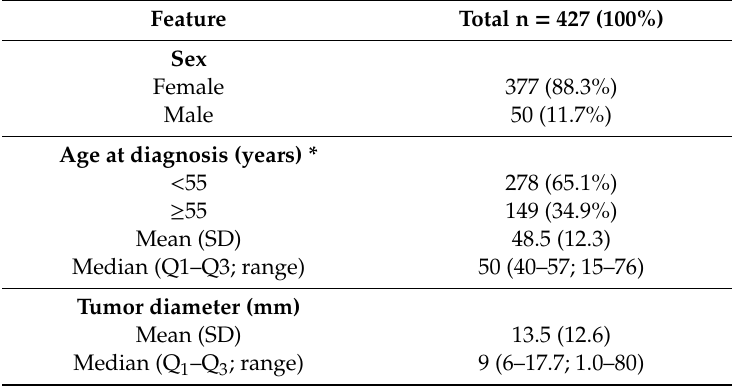
Table 1. Characteristics of 427 patients with papillary thyroid carcinoma (PTC) and their BRAF V600E and CHEK2 mutation